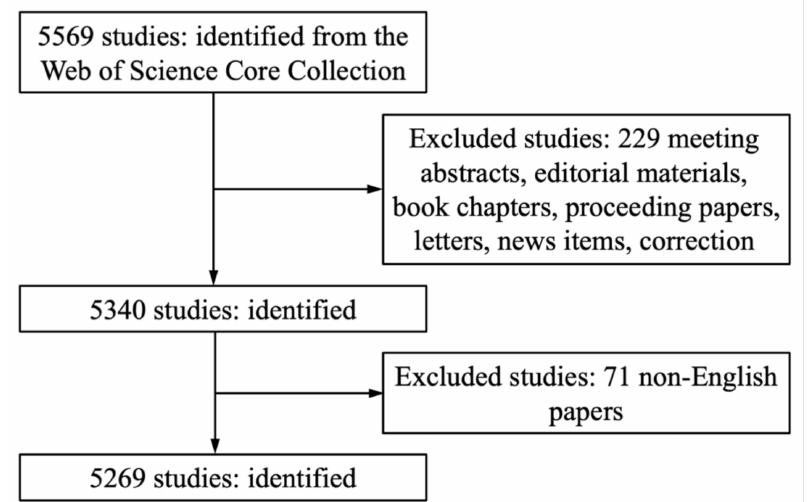
Figure 1. The process of retrieval and